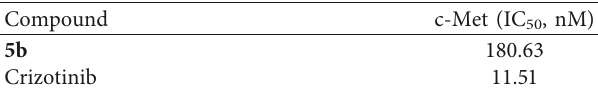
Table 2: Enzymatic activity of the compound 5b against c-Met